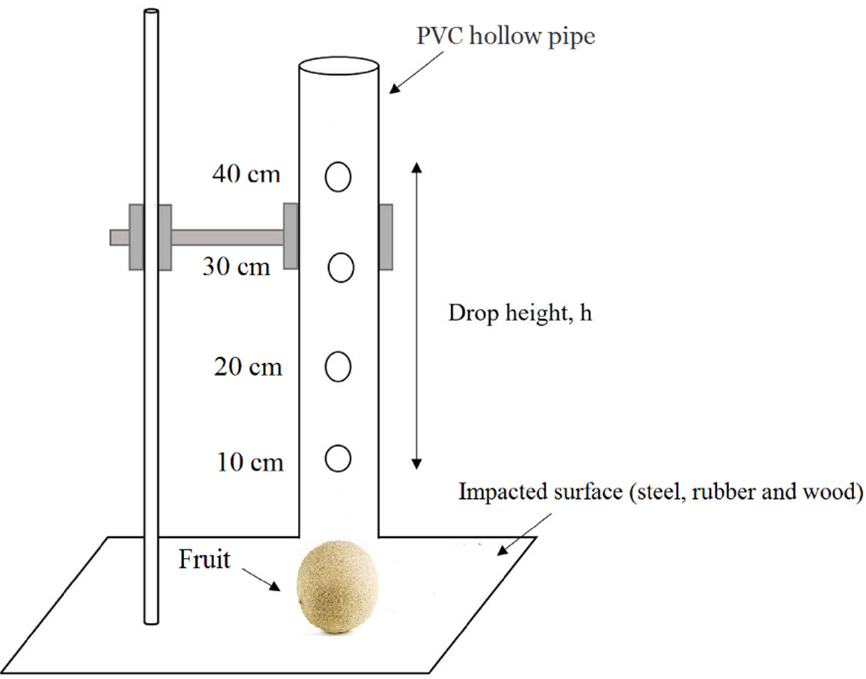
Figure 2. Experimental setup of impact testing in cantaloupe fruit.